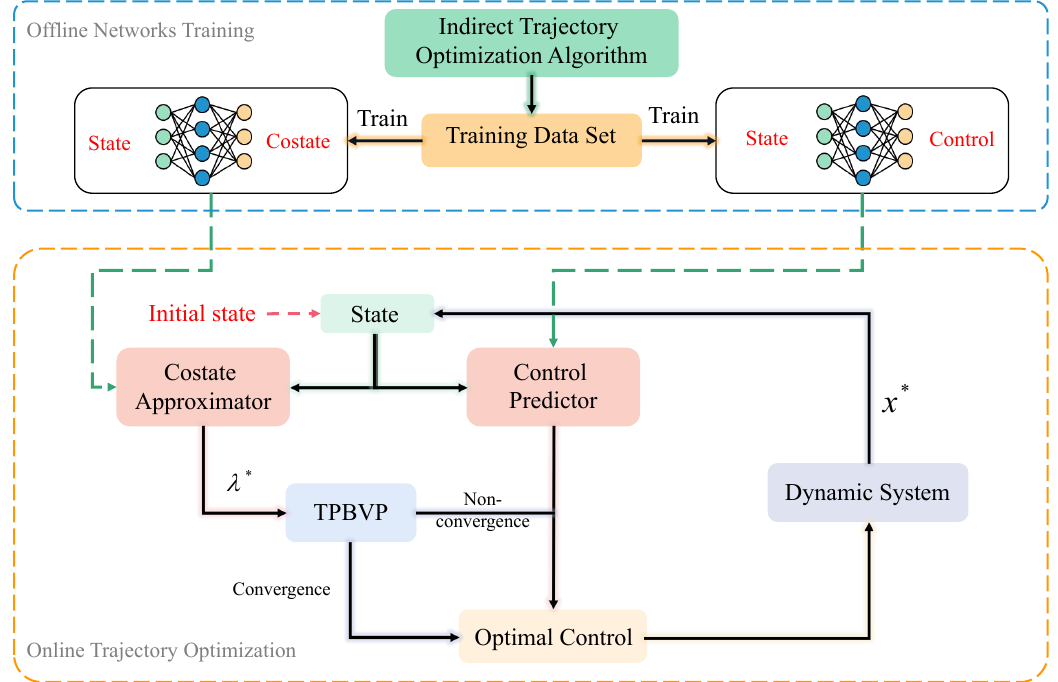
Figure 4. The proposed neural network-based warm-started indirect trajectory optimization